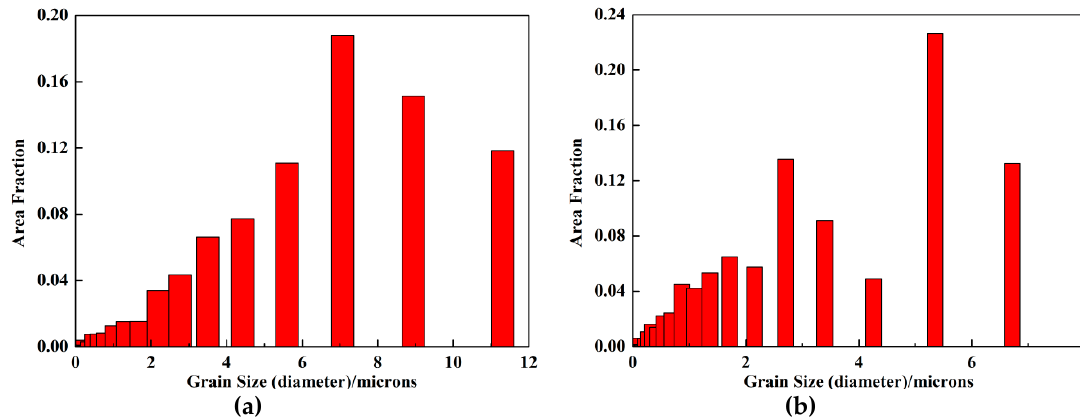
Figure 13. Statistical distribution of grain size in different deformation ratios; ( a ) ε = 0.607; ( b ) ε = 0.04.